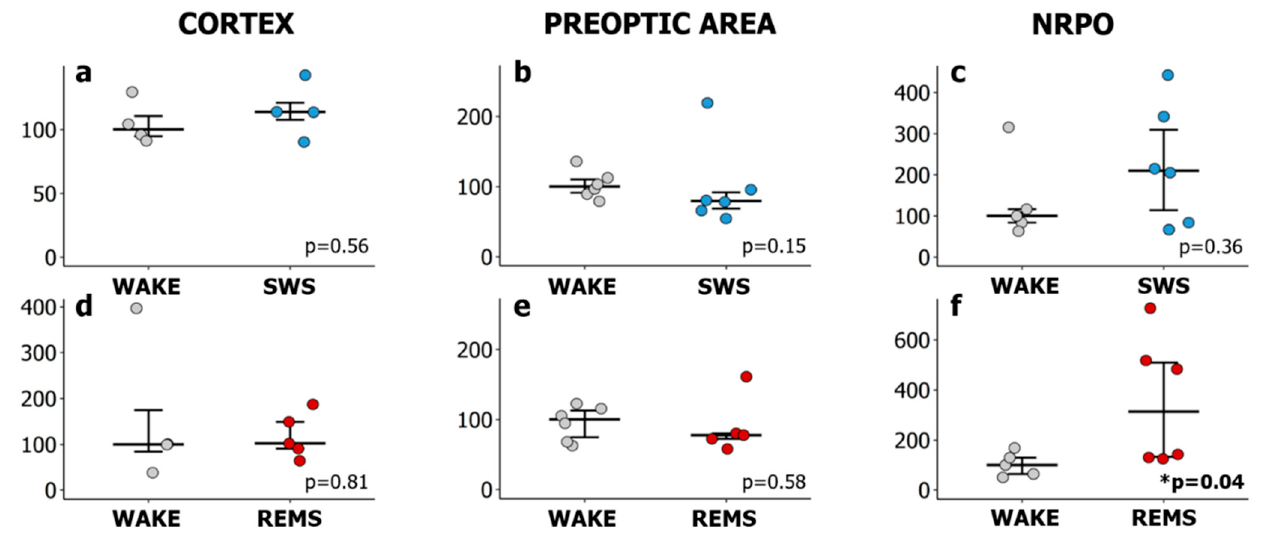
Figure 2. Hspa1 expression increases in the nucleus reticularis pontis oralis during the natural daily maximum of REM sleep in the lights-on period. Relative Hspa1 expression in ( a , d ) the sensorimotor cortex (CORTEX), ( b , e ) the preoptic area of the hypothalamus (PREOPTIC AREA) and ( c , f ) the nucleus reticularis pontis oralis (NRPO) in slow-wave sleep (SWS, upper row) or REM sleep (REMS, lower row). The values were calculated using the 2 −ΔΔ Ct method, where the reference group was in wakefulness either at ZT01-02 (for SWS) or at ZT07-08 (for REMS). WAKE (grey)—rats were sacrificed after a 10 min episode of wakefulness at ZT01-02 or ZT07-08, SWS (blue)—after 5–5.5 min episode of slow-wave sleep at ZT01-02, REMS (red)—after 2.5–3.5 min episode of REM sleep at ZT07-08. Values are shown as median ± 75/25 percentile. Each dot represents an independent sample (animal). p values were calculated using the Mann–Whitney U test with a corresponding “WAKE” group as a control.